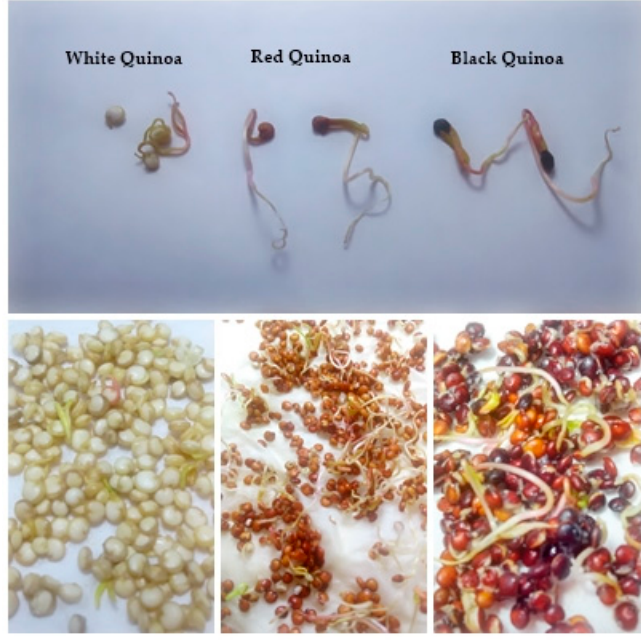
Figure 2. Germinated of white, red and black quinoa ( Chenopodium quinoa Willd) at 72 h of germination (G3).